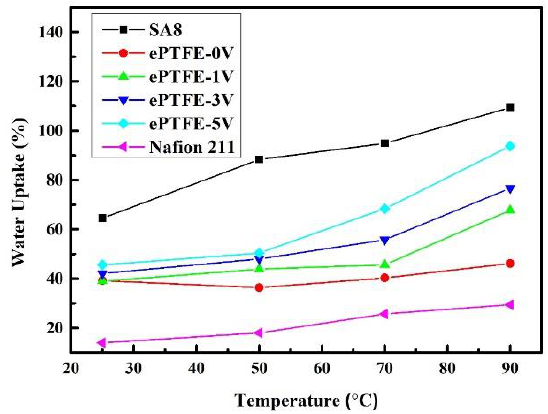
Figure 7. Water uptake of ePTFE membranes at various temperatures. Table 2. λ values of SA8 and eP TFE membranes.